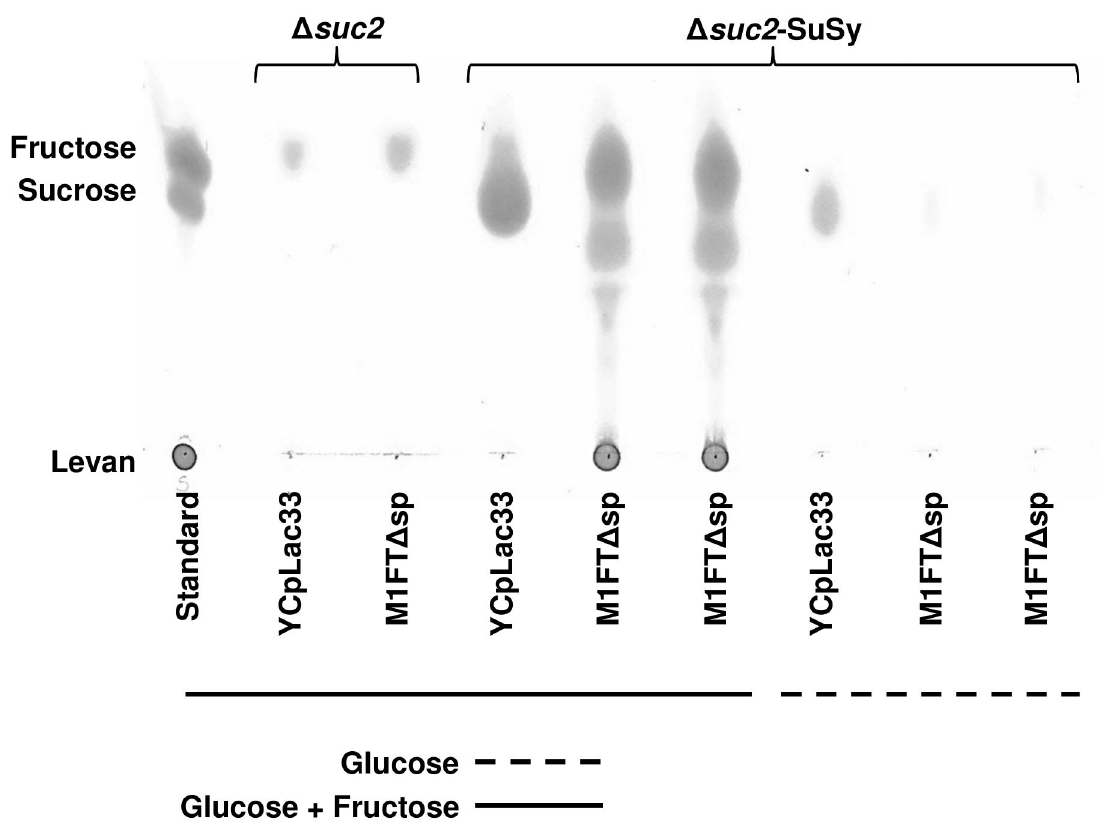
Figure 4. The potato sucrose synthase (SuSy) has lesser affinity for fructose 6-phosphate. Thin-layer chromatogram depicting extracts of BY4742Δ suc2 and BY4742Δ suc2 -SuSy strains transformed with M1FTΔsp and grown in minimal media containing either glucose or glucose and fructose to assess whether fructose 6-phosphate, originating from glucose can be used as substrate by SuSy. Strains grown in glucose and fructose are underlined with a solid line and strains grown in glucose only media with a dashed line. The decrease in sucrose formation in BY4742Δ suc2 -SuSy grown in glucose, compared to glucose and fructose illustrates that fructose 6-phosphate, synthesized from glucose, is not a preferred substrate for SuSy. TLC plates are representative of observations confirmed by at least three biological repeats. Fructose containing molecules were visualized using a urea spray after separation on TLC